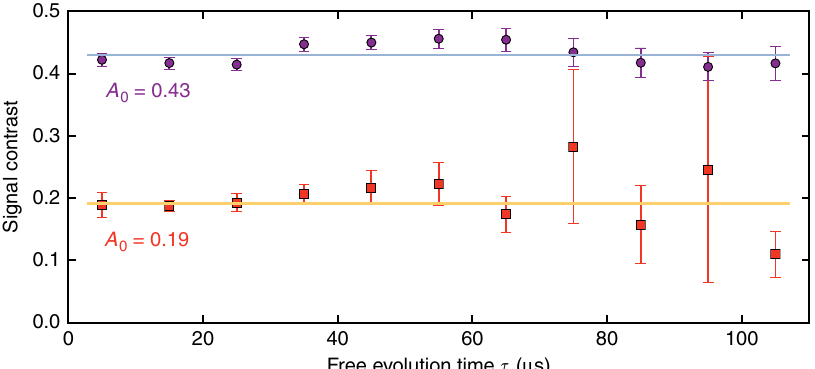
Figure 8 | Quantity of stored information for conventional and enhanced method. Analysis of fits to Fig. 2a,b, respectively. The initial signal contrast A 0 (that is, twice the initial amplitude of the decaying oscillation) is plotted for increasing sensing time t and for enhanced and conventional measurement sequence (top and bottom, respectively). The horizontal lines are weighted averages of the signal contrast for both cases and their values are given. As these values represent the case of zero correlation time T c ¼ 0 they are analogous to the spin echo measurement displayed in Fig. 1d. Please note, that the error bars give standard errors taken from the used least square